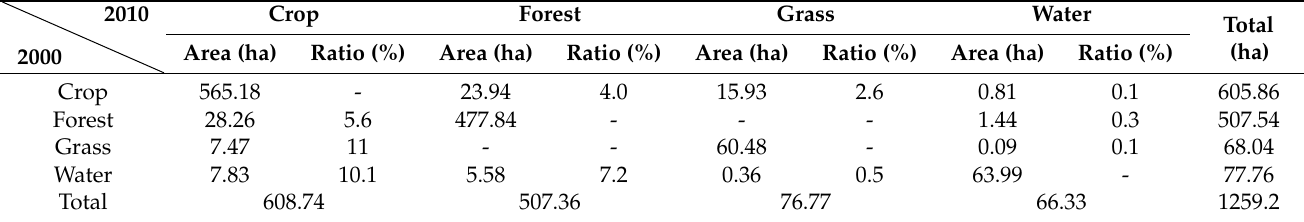
Table 3. Land cover transfer matrix from 2000 to 2010.